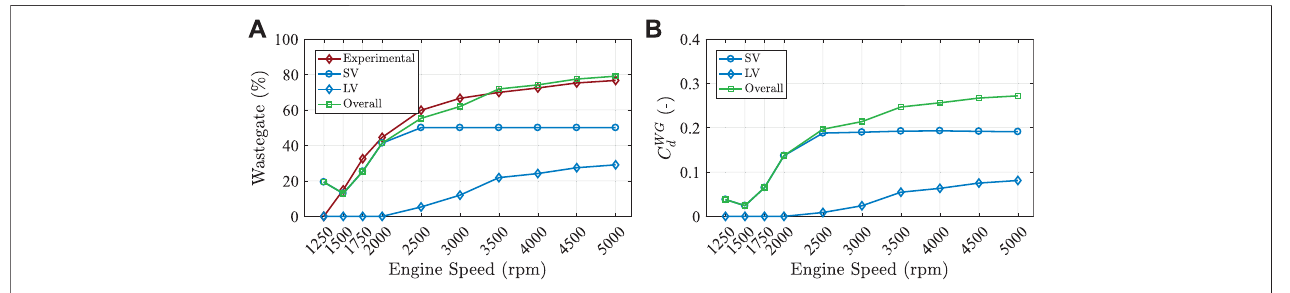
FIGURE 11 | CMT-DETCM model wastegate positions and the estimated discharge coef fi cient values at different engine speeds.